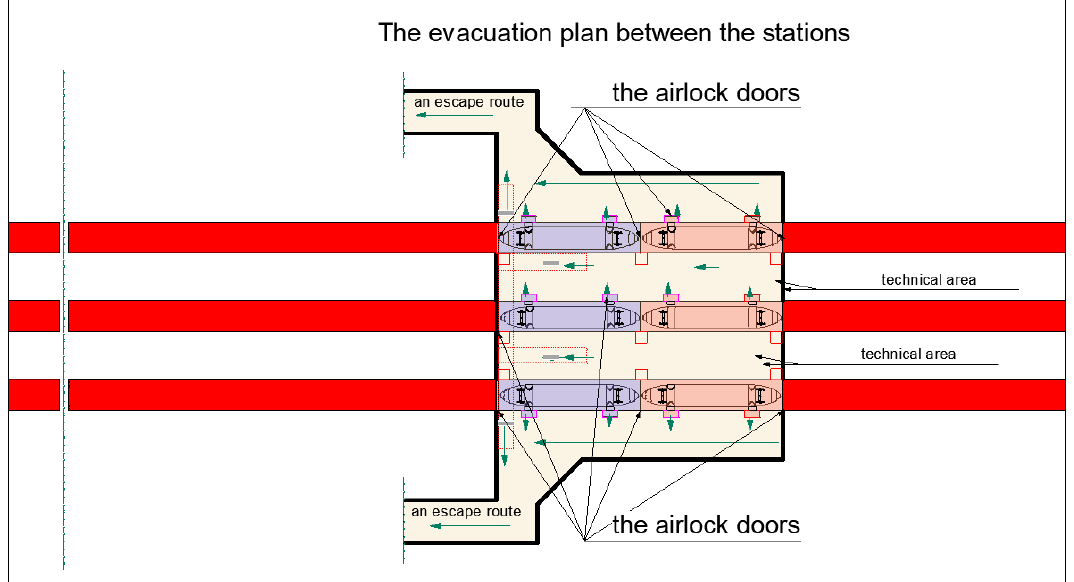
Figure 9. An emergency sector located in the Hyperloop tube.